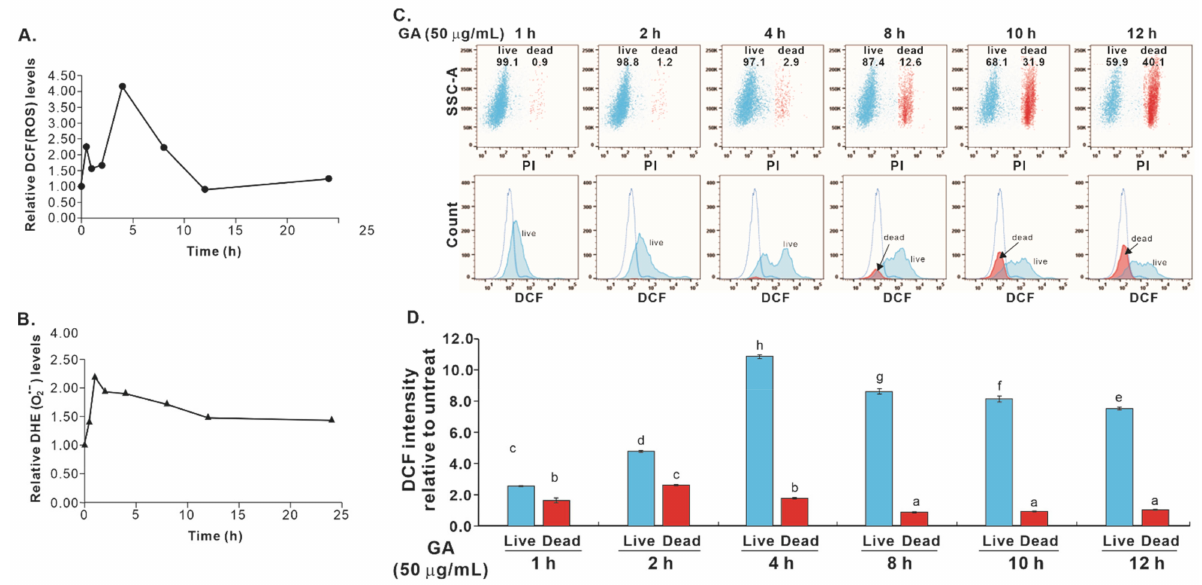
Figure 5. The effect of GA treatment on the intracellular ROS level of CL1-0 cells expressing PERP- 428C . ( A ) ROS levels in CL1-0/ PERP-428C cells within 24 h after GA treatment as determined by H 2 DCFDA. ( B ) DHE measures the level of superoxide anions in CL1-0/ PERP-428C cells within 24 h